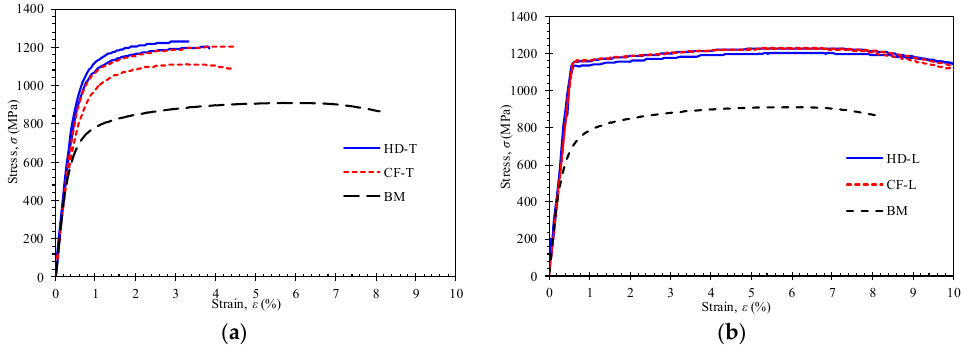
Figure 5. Stress–strain curve of 34CrMo4 for the ( a ) transverse (T) specimens and ( b ) longitudinal (L) specimens.